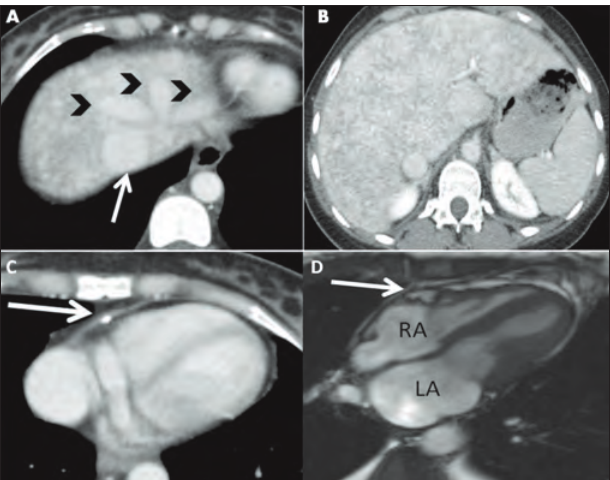
Fig. 1. Axial post contrast-enhanced CT scans of the abdomen in a 26-year- old woman with a history of abdominal pain, generalised swelling and bloating. (a ) CT scan through the upper abdomen demonstrates dilated inferior vena cava (arrow) and hepatic veins (arrow heads). (b) CT scan through the upper liver demonstrates a mildly enlarged liver with diffuse heterogeneous enhancement in keeping with hepatic venous congestion. (c) Post contrast images through the lower chest on abdominal CT scan demonstrate some pericardial thickening with foci of pericardial calcification adjacent to the basal right ventricle and atrio-ventricular groove (arrow). (d) The four-chamber cine steady-state free precession (SSFP) cardiac MRI image demonstrates biatrial enlargement with small biventricular volumes. Pericardial thickening is also noted adjacent to the atrio-ventricular groove (arrow). Bilateral pleural effusions are also seen (LA = left atrium; RA = right